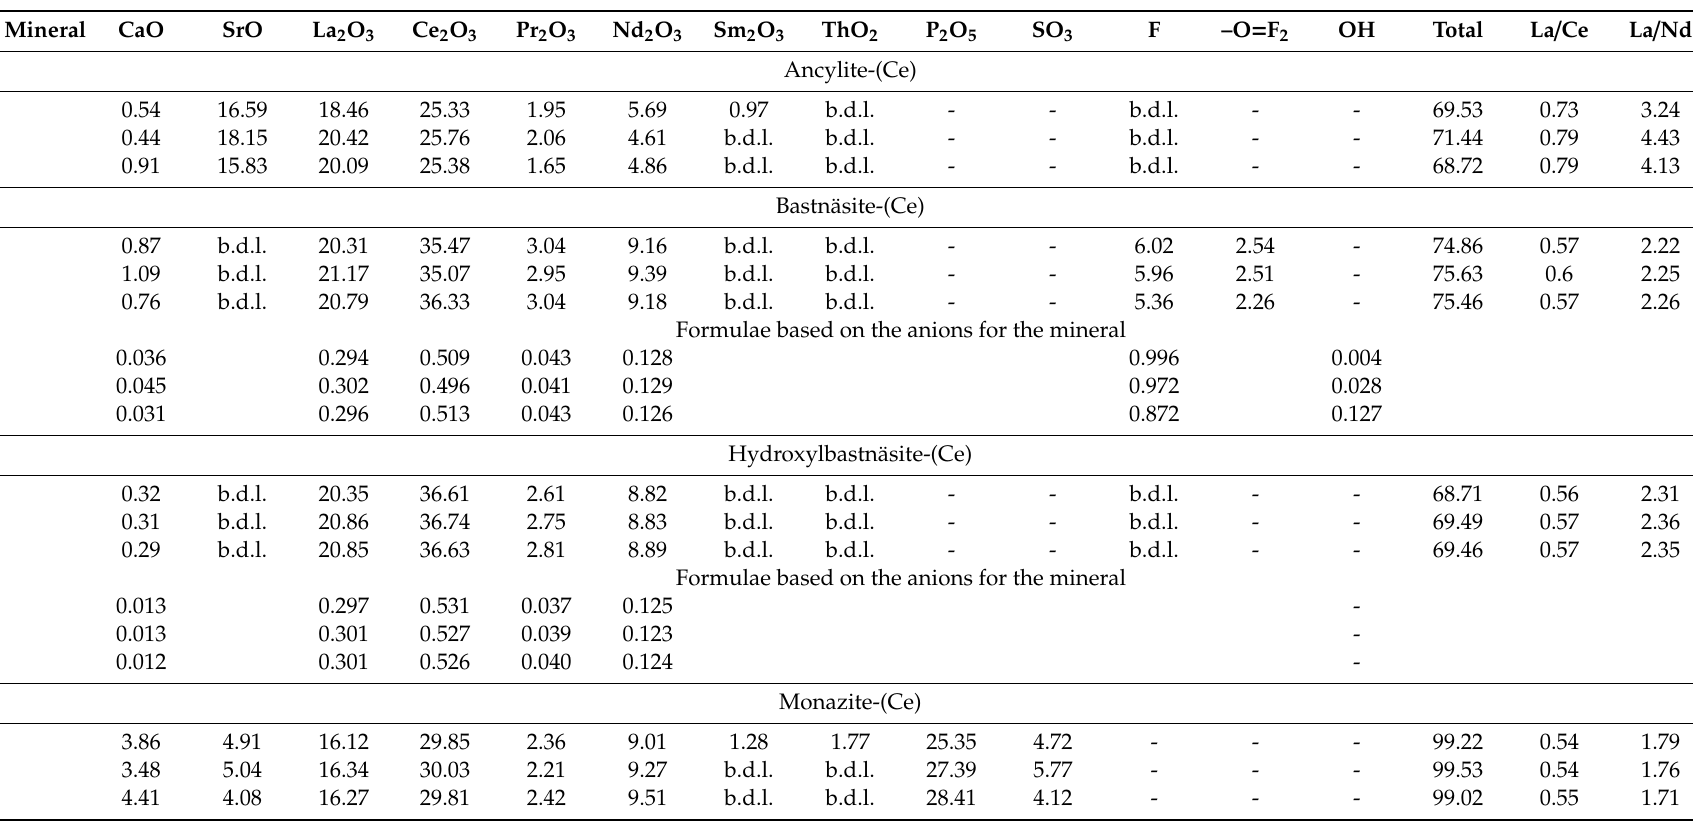
Table 2. The mineral composition of the rare earth element (REE) mineral phases of Petyayan-Vara “ancylite ores”, “bastnäsite ores”, and hybrid rocks. Representative analyses